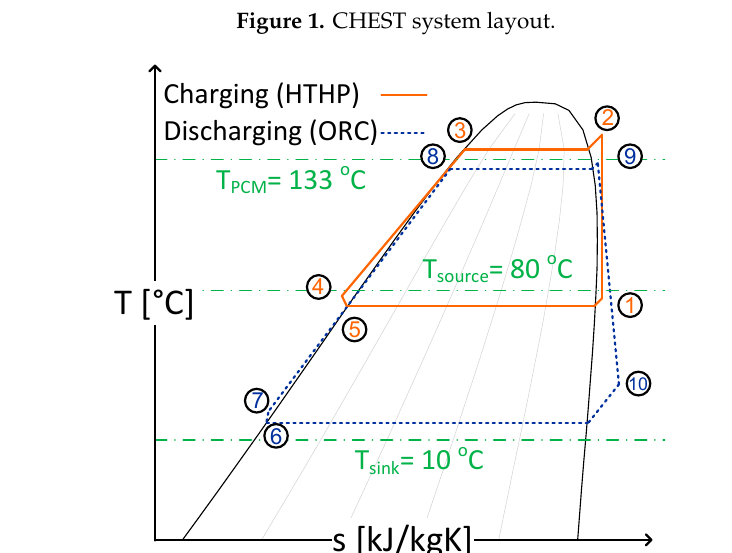
Figure 2. Temperature-entropy ( T-s) diagram of the charging and discharging cycles with the CHEST system.